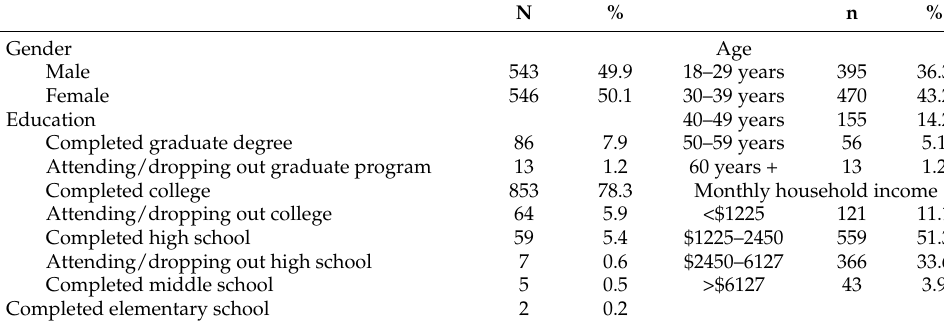
Table 1. Sample characteristics (n =